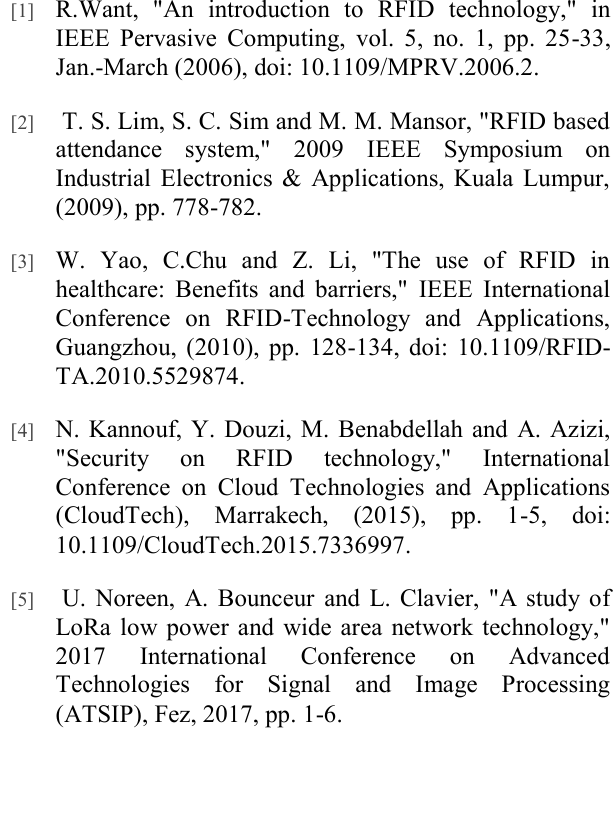
Fig. 9 . Message displayed on LCD screen Fig. 7. LoRa sender output display on the Arduino IDE Table 1. Read range testing of RFID reader The values given on the first four lines are the last